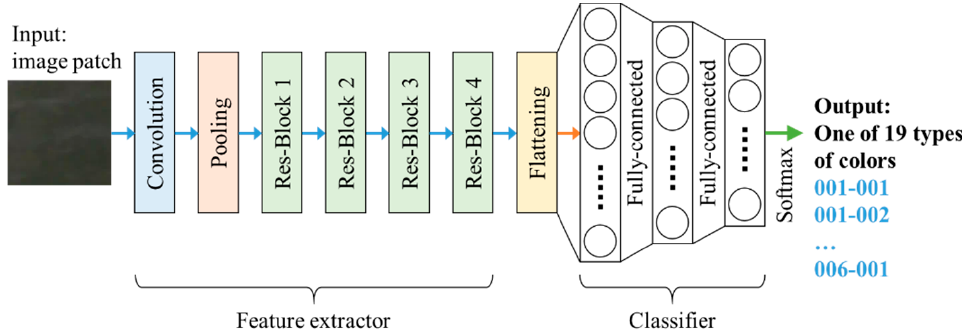
Figure 11. Deep CNN with ResNet-50 backbone for water color identification.